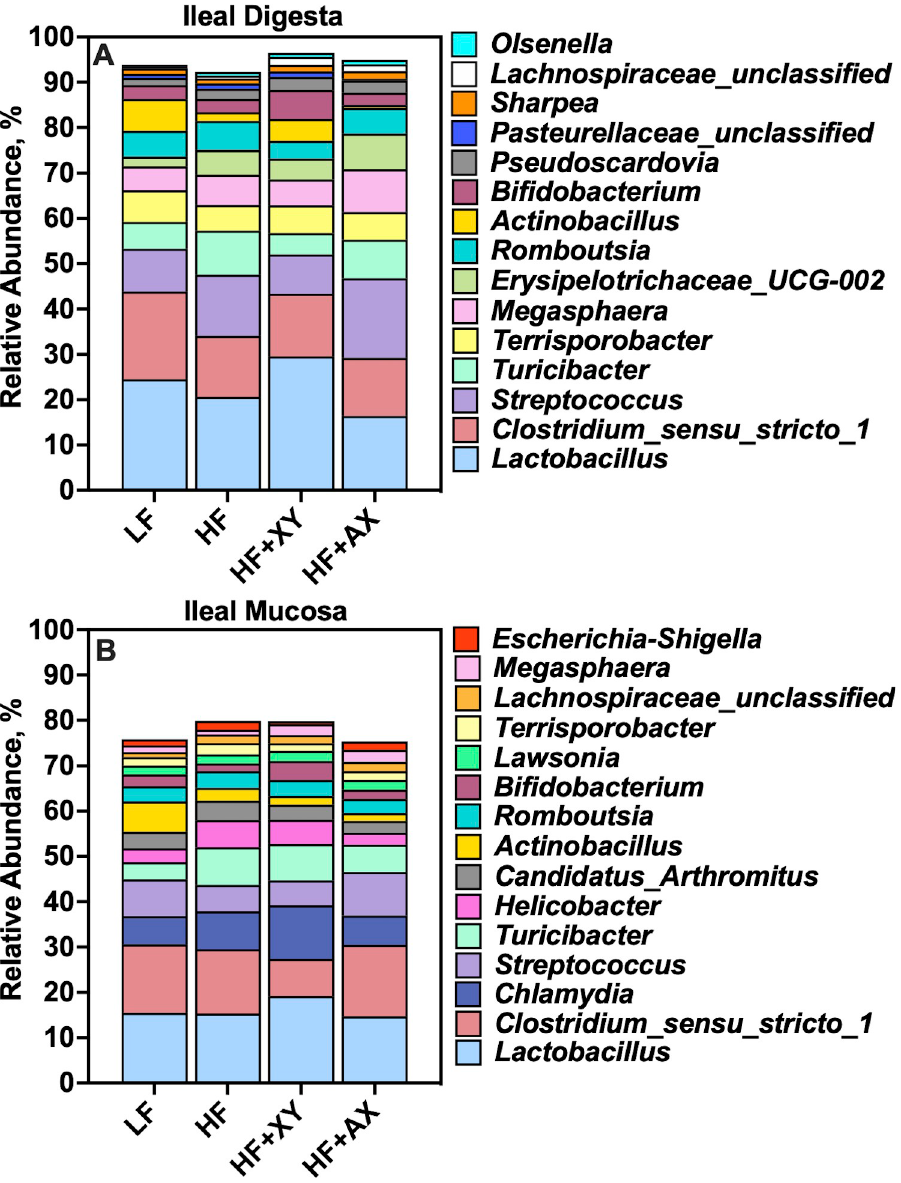
Fig 3. The relative abundance of the 15 most abundant genera among treatments present in the ileal digesta and mucosa.